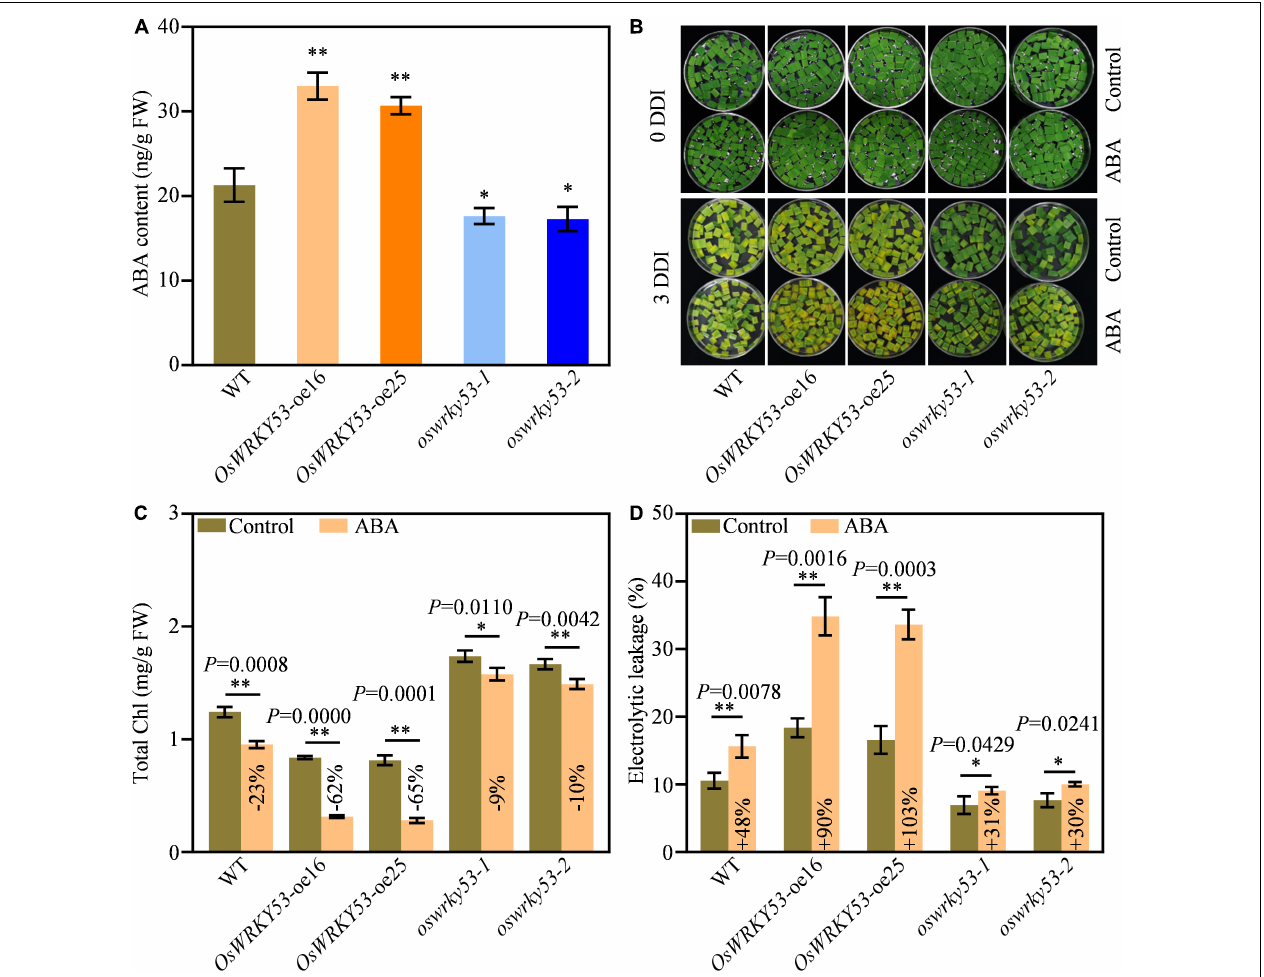
FIGURE 4 | Accumulated ABA promotes leaf senescence in OsWRKY53 -oe plants. (A) ABA contents in flag leaf of OsWRKY53 -oe, oswrky53, and wild type (WT). Asterisks indicate a significant difference between transgenic plants and WT determined by two-tailed Student’s t -test at ∗∗ p < 0.01 or ∗ p < 0.05. (B) Phenotype of detached flag leaf of OsWRKY53 -oe, oswrky53 , and WT at 3 days of dark incubation (DDI) in the presence of 50 mM ABA and control. (C) Chlorophyll content of detached flag leaf of OsWRKY53 -oe, oswrky53 , and WT at 3 DDI in the presence of 50 µ M ABA and control. (D) Ion leakage analysis of detached flag leaf of OsWRKY53 -oe, oswrky53, and WT at 3 DDI in the presence of 50 µ M ABA and control. Data represent mean ± SD. Asterisks indicate a significant difference between exogenous ABA treatment and control determined by two-tailed Student’s t -test at ∗∗ p < 0.01 or ∗ p <